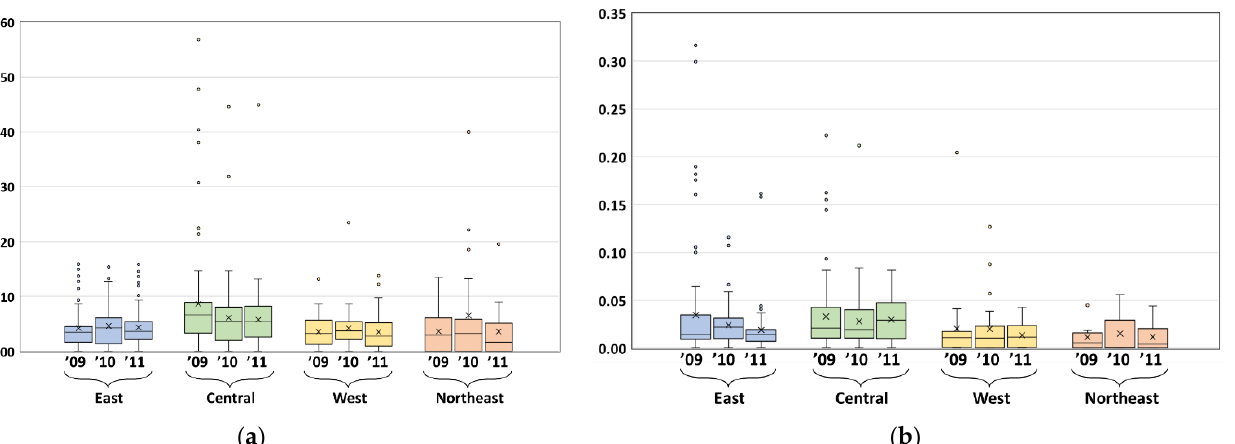
Table 2. Summary of the changes for each inefficiency factor and its components in the SM group. The percentage in parentheses represents the proportion of each factor to meta inefficiency.